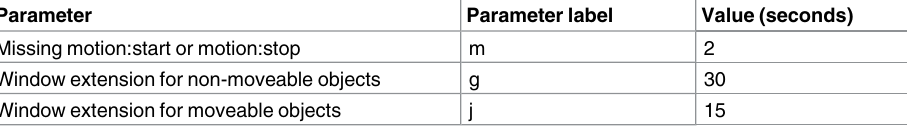
Table 2. Parameter values in activity recognition